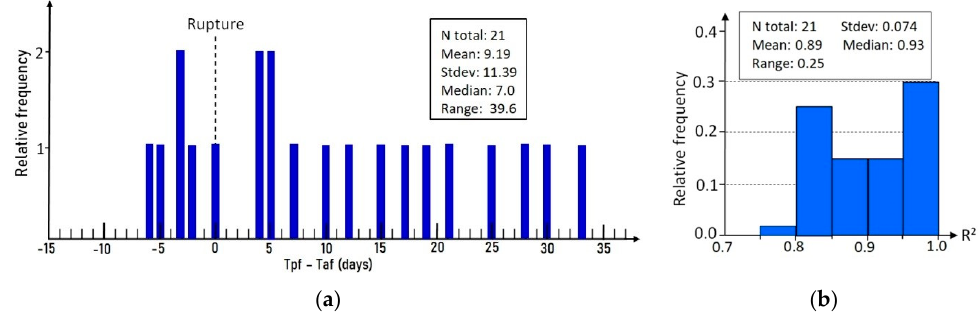
Figure 14. PSI relative frequency distribution of the errors ( a ) and R 2 coe ffi cient from the inverse velocity predictions ( b ).